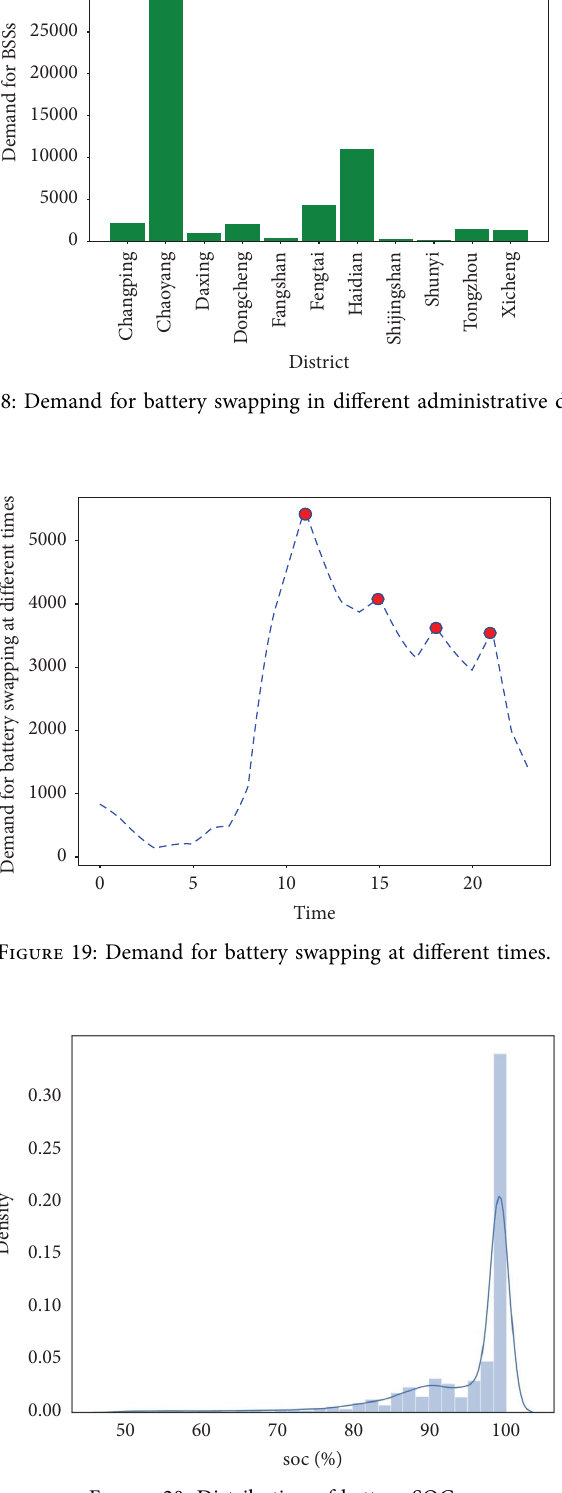
Figure 20: Distribution of battery